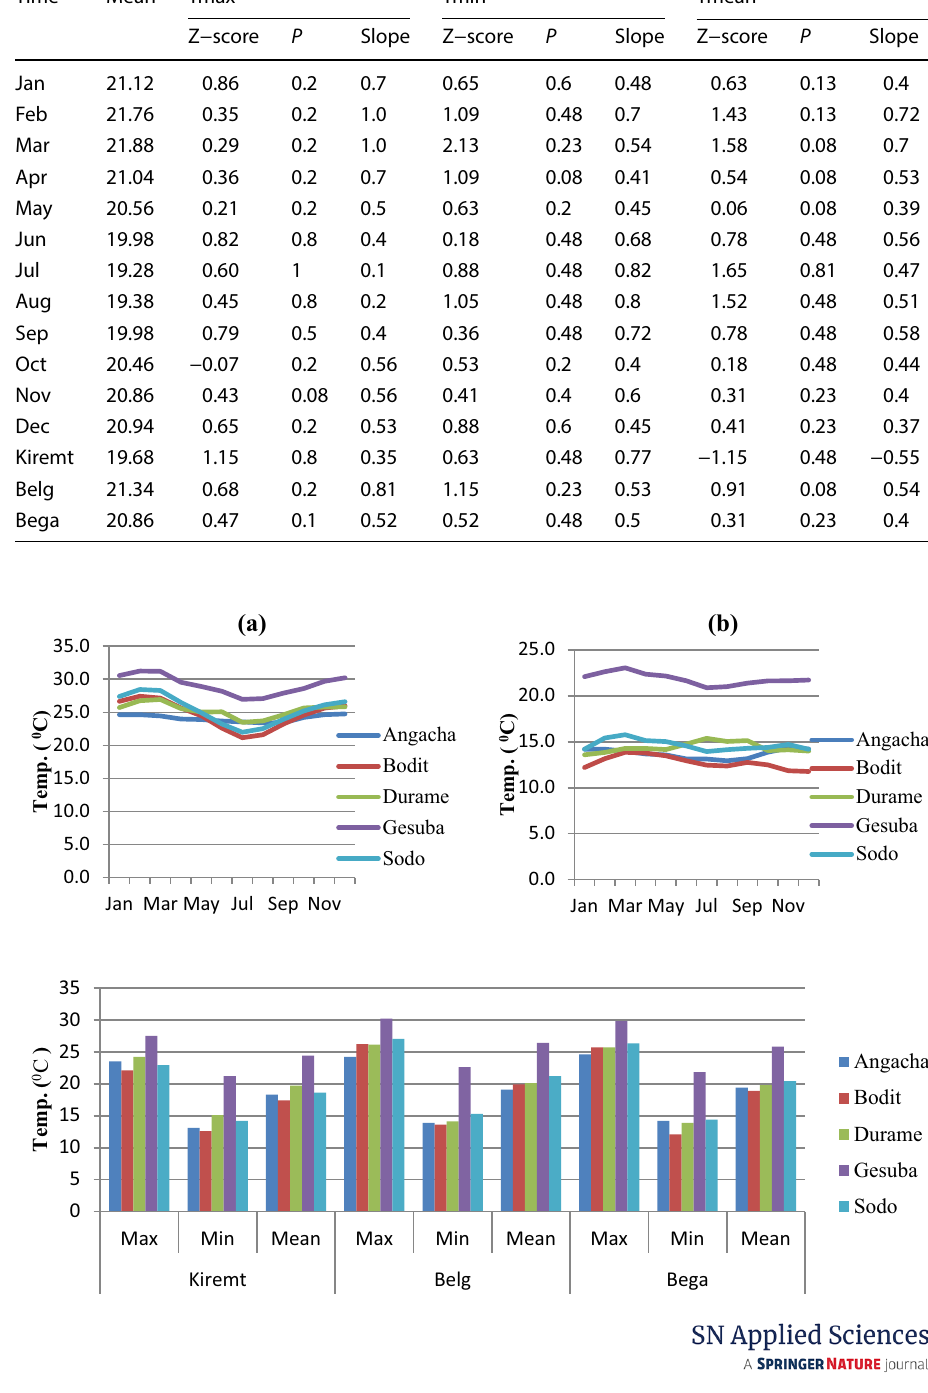
Table 7 MK test result of monthly and seasonal Temperature